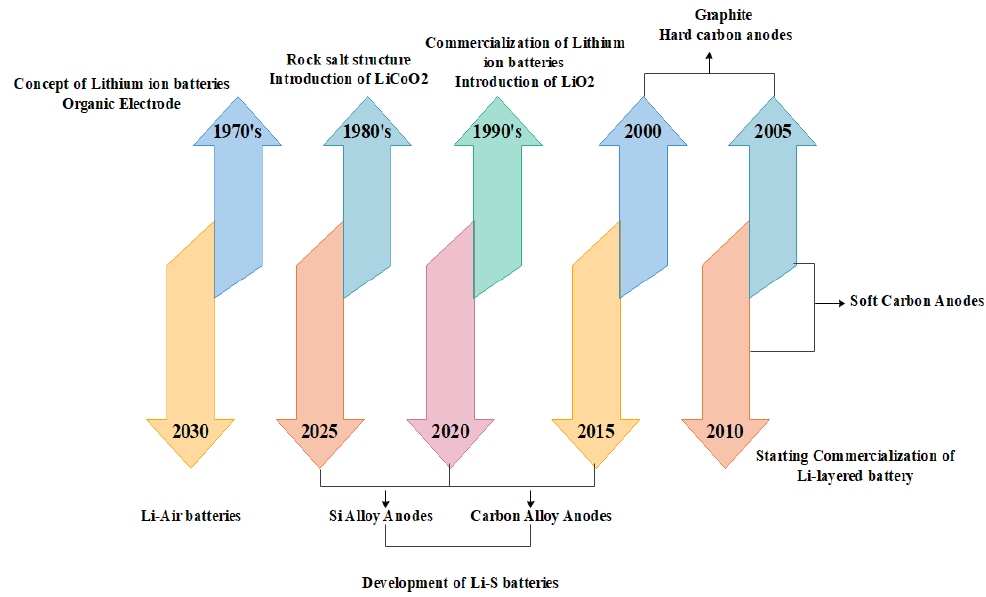
Figure 1. Evolution of lithium-ion batteries.